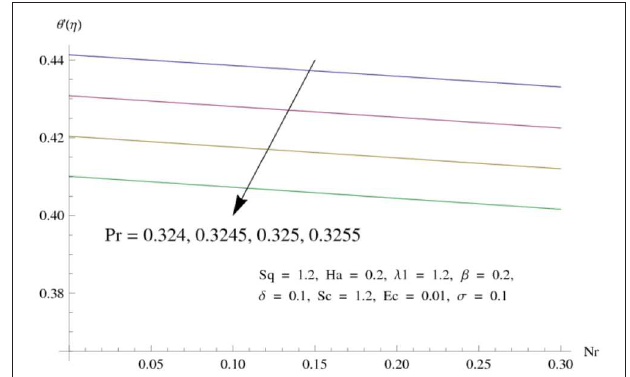
FIGURE 14 | Behavior of N r & Pr on Nu .